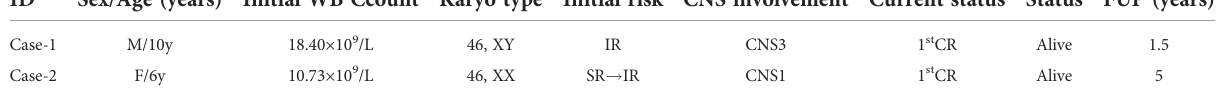
TABLE 1 Clinical characteristics of ALL with TCF4-ZNF384 fusion